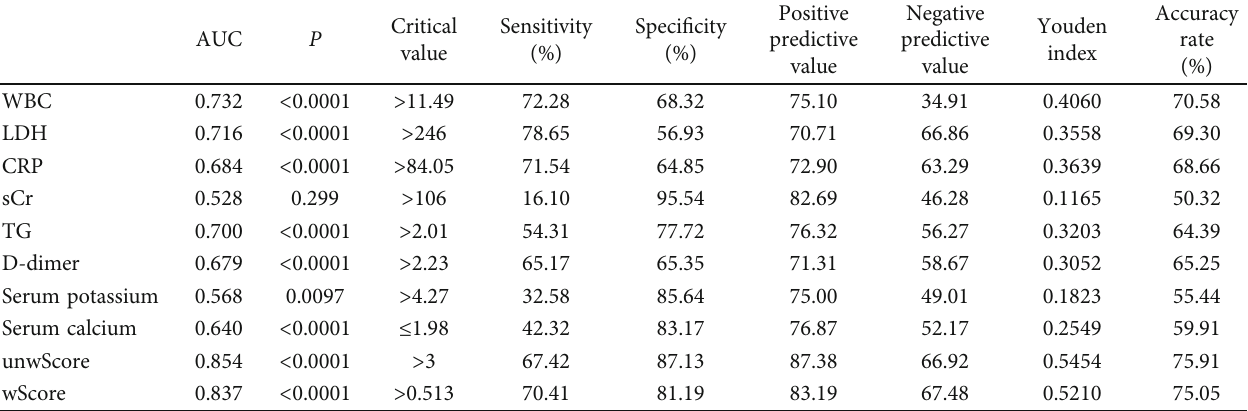
Table 4: The predictive values of independent prognostic indexes and predictive models of MSAP and